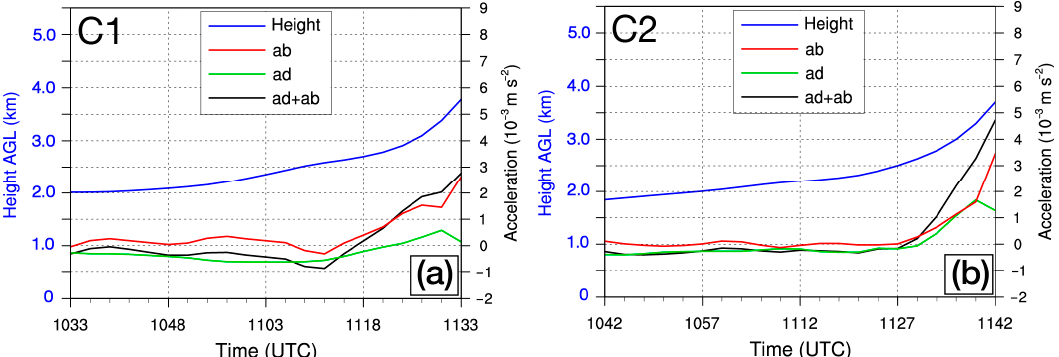
Figure 10. ( a ) Averaged height and vertical momentum components induced by buoyancy ( a b ), dynamical force ( a d ) and sum of them ( a b + a d ) along all air parcels selected within the C1. ( b ) is the same as ( a ) but for the C2.